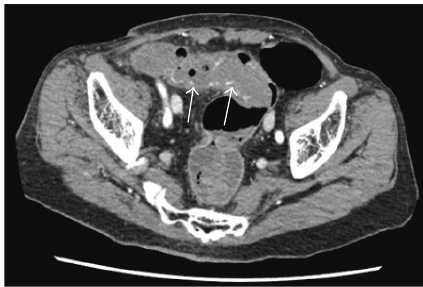
Figure 1: Helical computer tomographic angiography revealing the bleeding from the sigmoid colon (arrows).